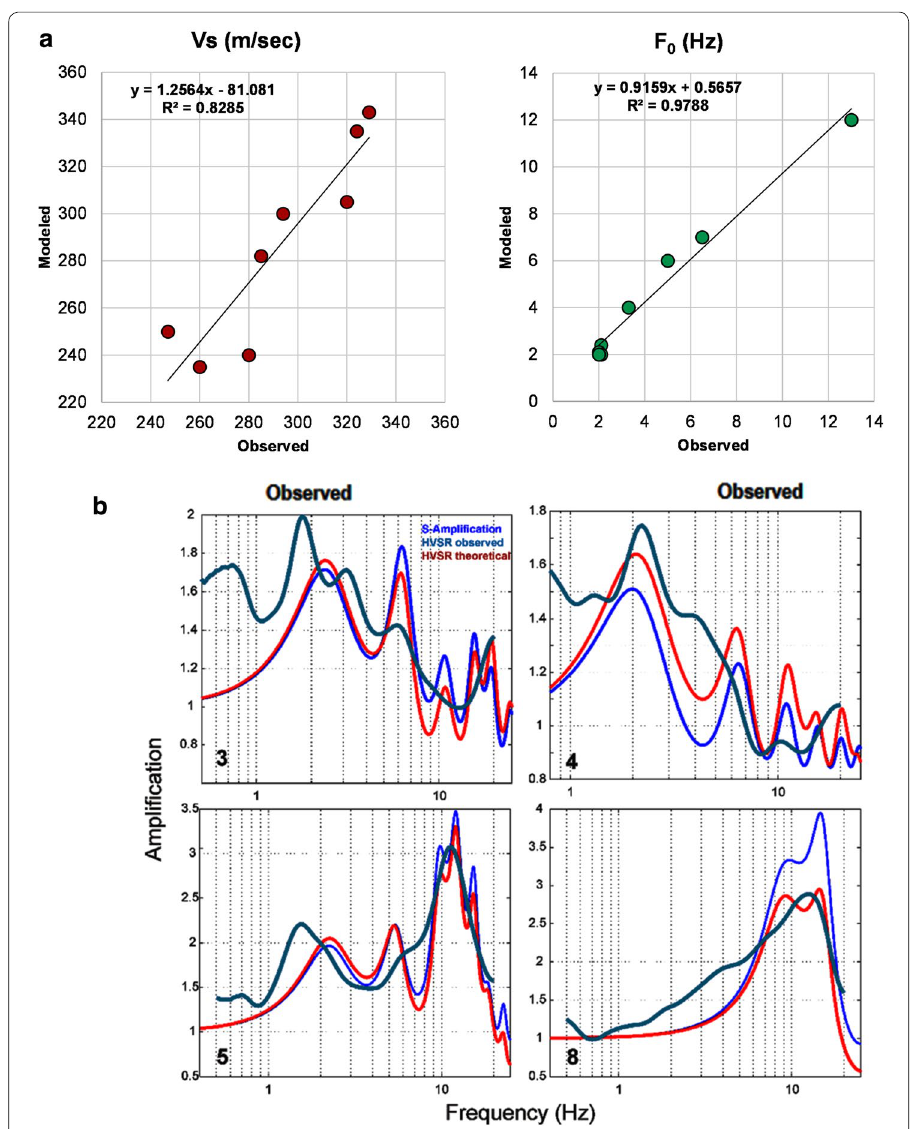
Fig. 8 Diagrams showing the correlation between the 1D numerical modeling with the empirical site response regarding ( a ) V s and F 0 , ( b ) Surface-to-rock amplification. Numbering at the lower left corner of the panels indicate the code of the observation point as it is presented in column 1 of Table 2 and Fig.